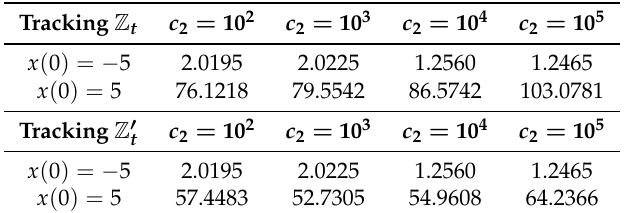
Table 2. Comparison of the transient economic performance target zone Z t and EMPC tracking the modified zone Z (cid:48) t